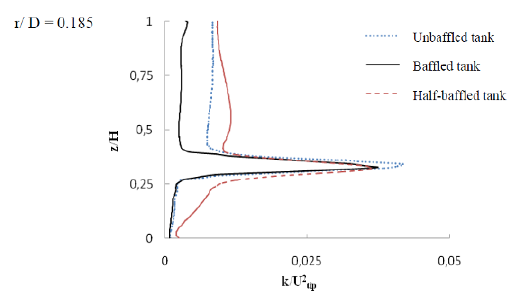
Figure 9. Axial profile of the turbulent kinetic